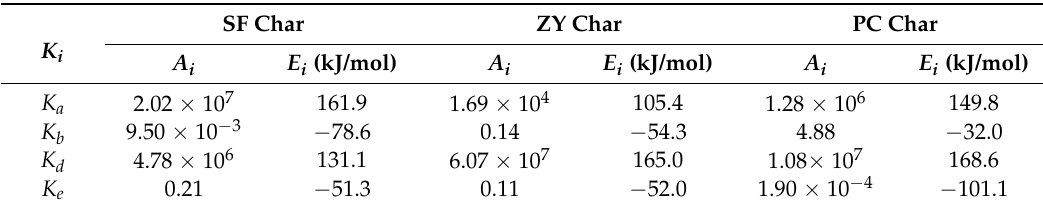
Table 2. Kinetic parameters of char–CO 2 and char–steam reactions.